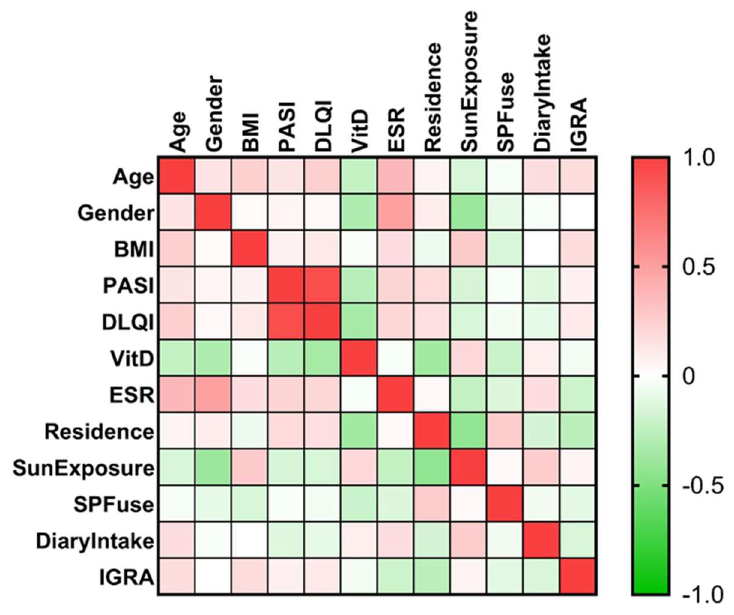
Figure 2. Heatmap of the correlation matrix.